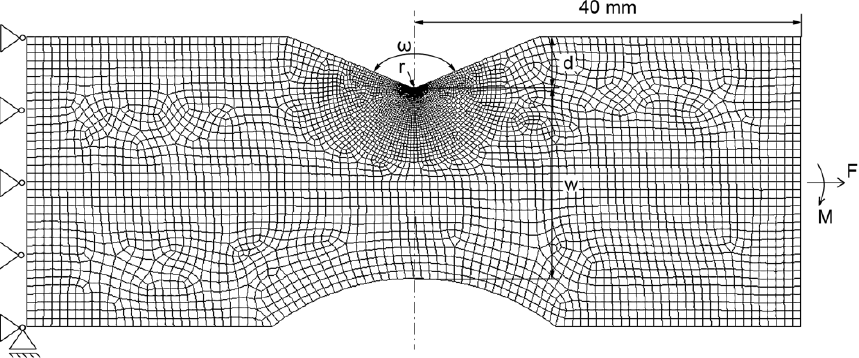
Figure 8. Parametric finite element model of the investigated specimens presented exemplarily for one specimen of series